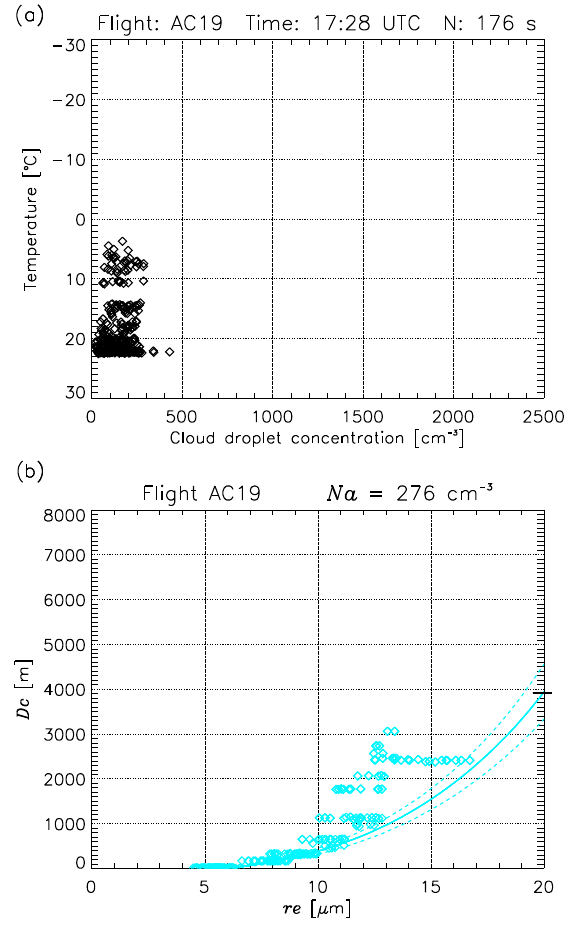
Figure 8. (a) Cloud droplet concentrations measured with the CCP– CDP as a function of temperature for flight AC19. Each dot indi- cates 1Hz average concentration. The sample number in seconds ( N ) and the start time of the cloud profile are shown at the top of the panel; (b) similar to Fig. 7 for flight